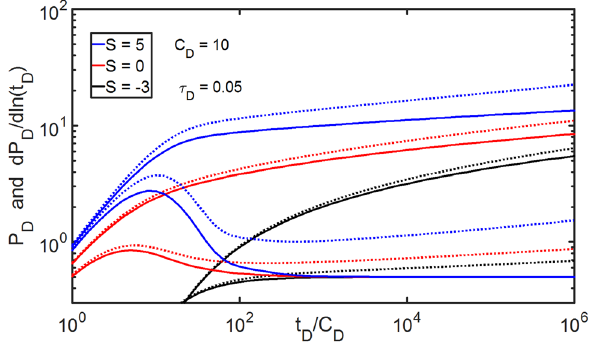
Fig. 5 Pressure and pressure derivative, non-linear (unbroken curves) and linear (solid) responses